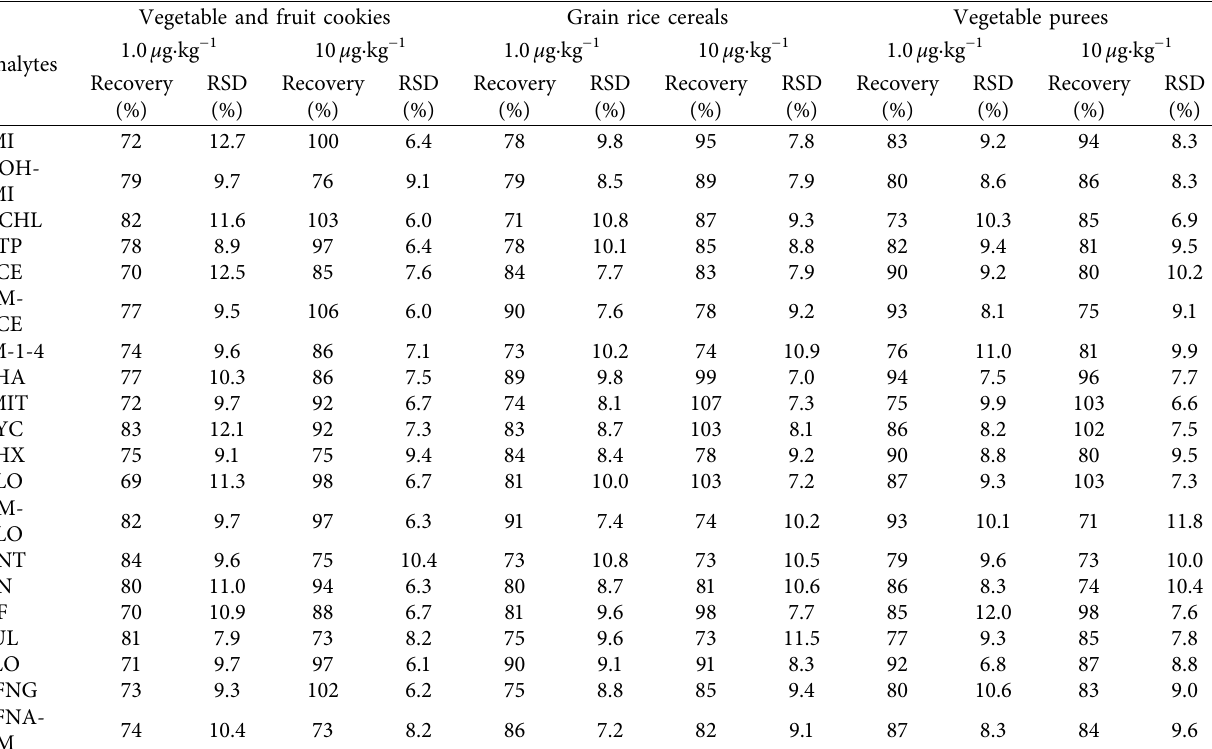
Table 3: Recovery rates of all target compounds spiked in three different matrices at two different concentrations (interday n � 6). Vegetable and fruit cookies Grain rice Analytes